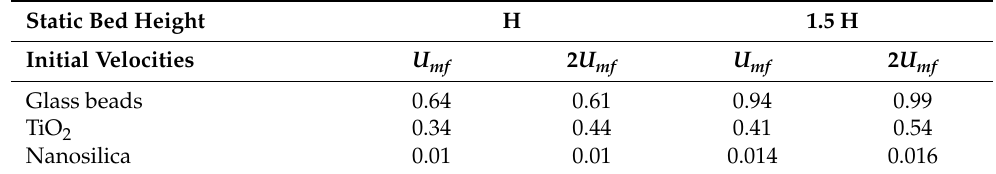
Table 3. Maximum initial airflow (LPM) through purge during collapse evaluated from Figure 12.